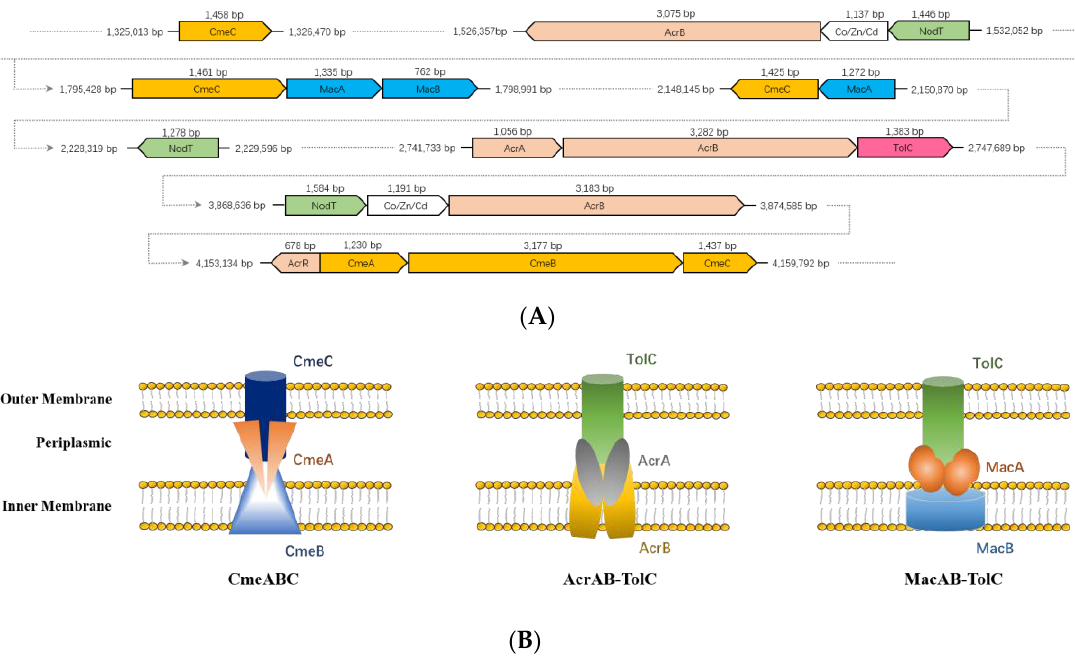
Figure 7. The gene clusters of RND and ABC type efflux pump in the genome of strain CHu59-6-5 T ( A ). Three types of tripartite efflux pump. From left to right, CmeABC pump, AcrAB-TolC pump and MacAB-TolC pump ( B ).